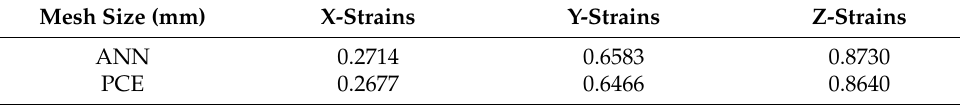
Table 4. L2-error norm between predicted and experimental